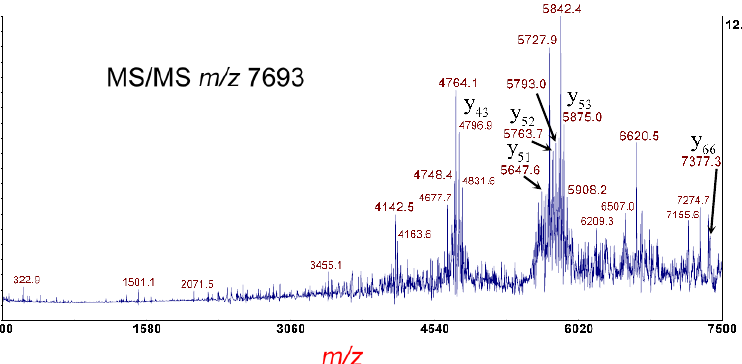
Figure 5. Top panel: MS analysis of E. coli O145:H28 strain RM14496-C1 cultured overnight on LBA supplemented with 800 ng/mL of mitomycin-C. The putative disulfide-bond-intact B-subunit of Stx1a is indicated. Bottom panel: MS/MS analysis of the putative B-subunit at m/z 7693 in the top panel. Fragment ions are indicated by their m/z and b- or y-type designations. The sequence of the Stx1a B-subunit is shown. A red asterisk indicates sites of polypeptide backbone cleavage that generate the corresponding fragment ions shown above (y-type) or below (b-type) the sequence. Acidic residues are highlighted in red and basic residues in blue. Cysteine residues are boxed, and a connector line symbolizes the intramolecular disulfide bond.